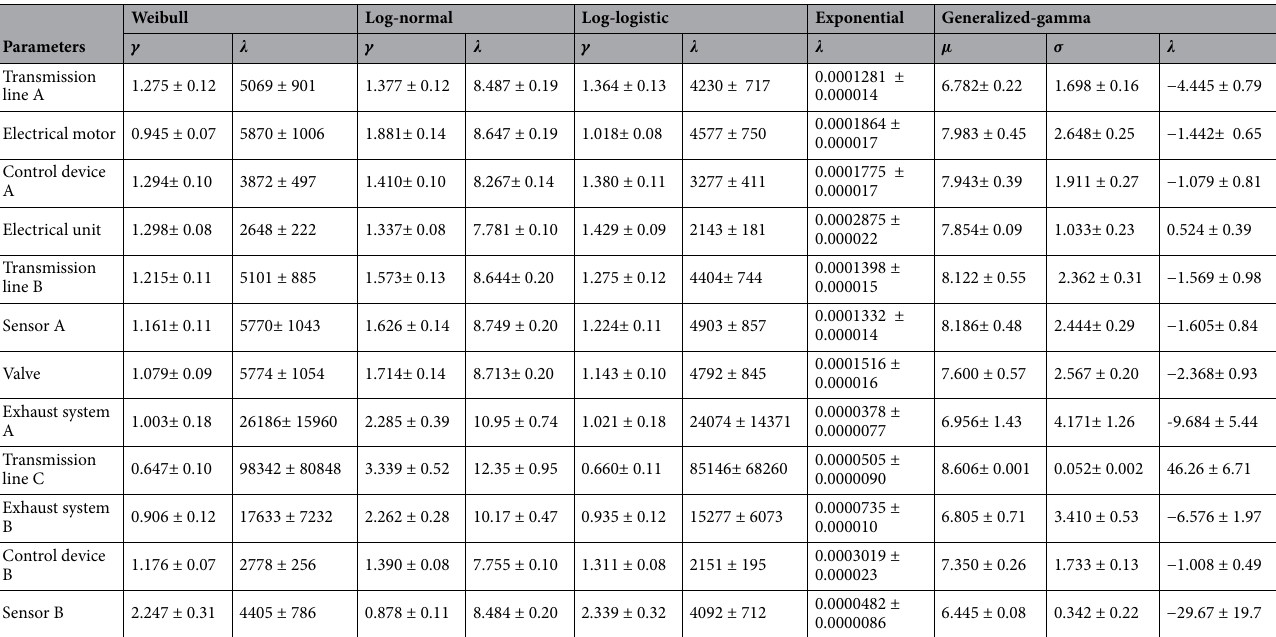
Table 1. Estimated parameters and their standard errors for all the parametric hazard estimations from Figs. 7, 8, 9, 10, 11. Equations of the parametric models and their corresponding parameters see Fig. 1.